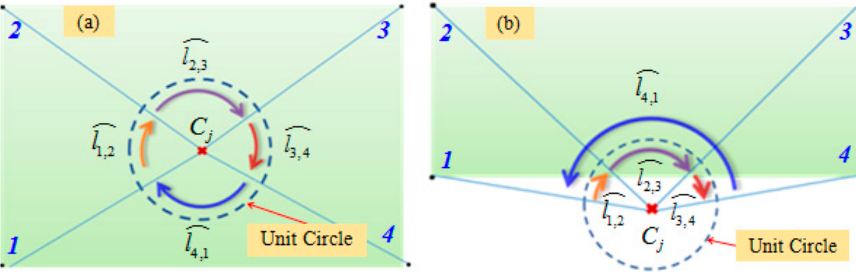
Figure 6. Schematic diagram of the directed arc-length method: ( a ) point inside the boundary; and ( b ) point outside the boundary.